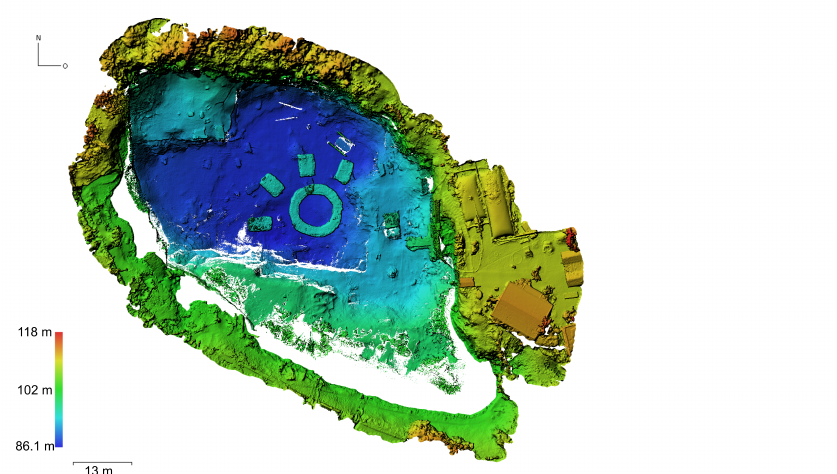
Figure 13. Result of the reconstruction underwater and landscape model combined to the EPSG::25,833 coordinate